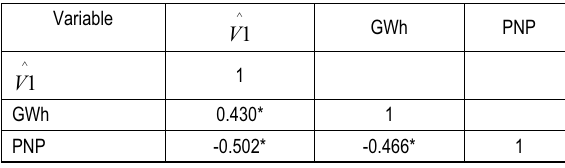
Table 5. Correlation matrix (Pearson’s correlation)